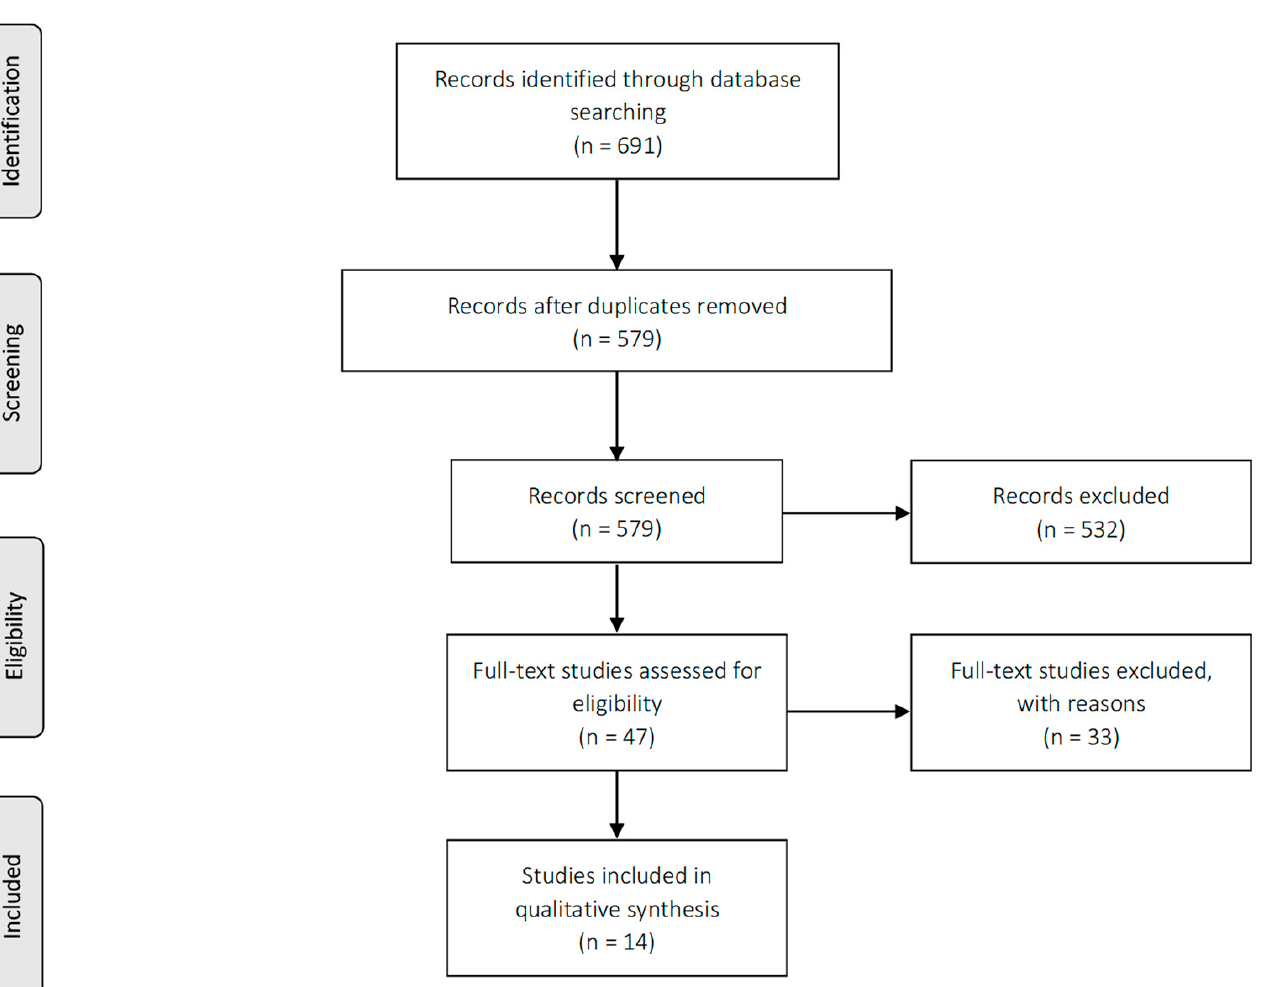
Figure 1. PRISMA flow chart.